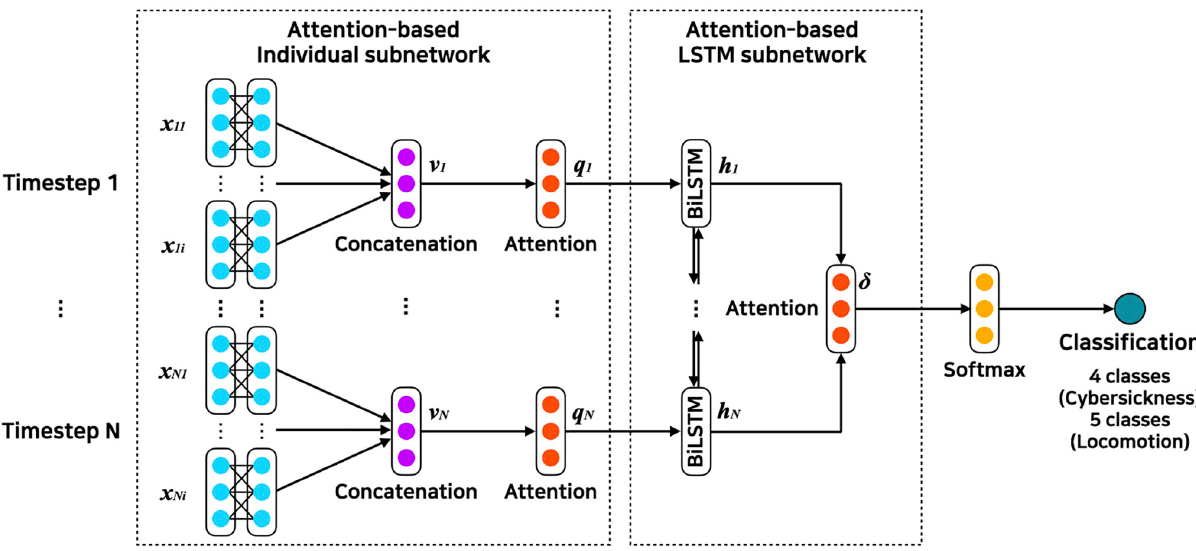
Fig 3. Model architecture used in two studies. The model mainly consists of the attention-based individual network and the attention-based LSTM subnetwork. The cybersickness study has four classes, and the locomotion study has five classes ( N means time t , which is t = 1,2, ... , N ).